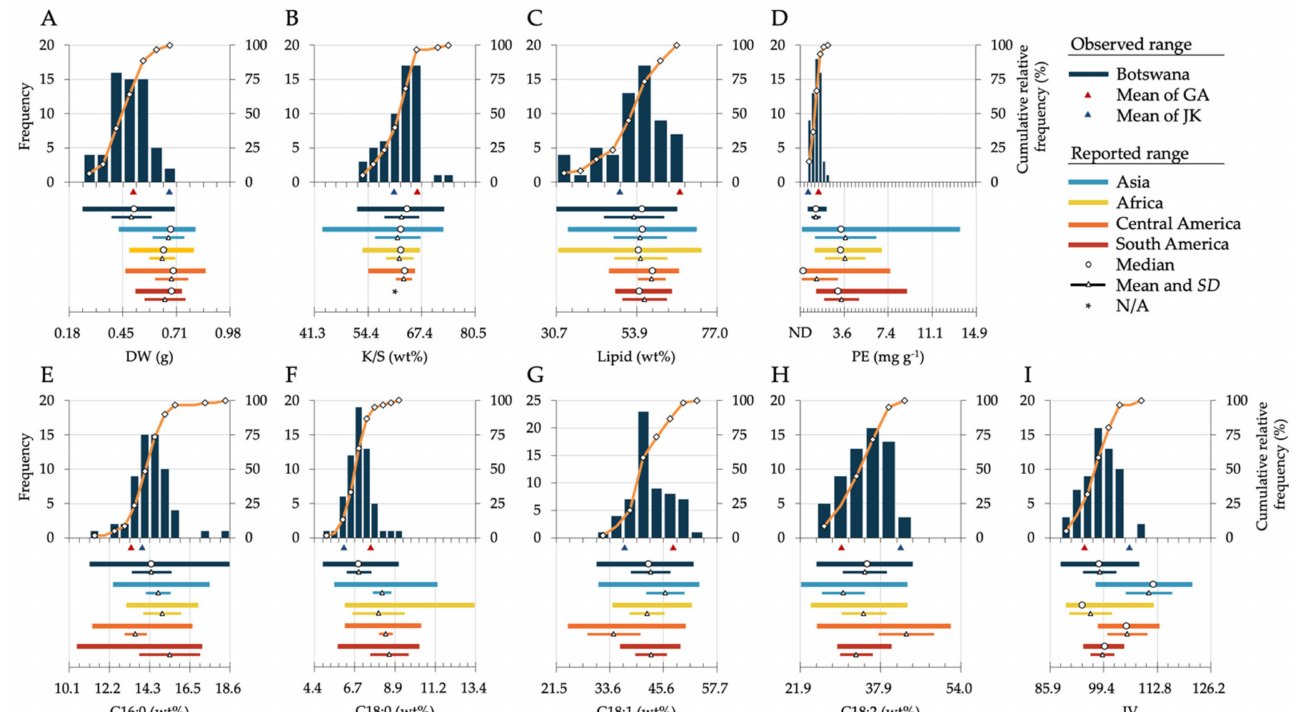
Figure 2. Frequency distribution histograms of seed physicochemical traits for the Botswanan accessions. The ( A ) dry seed weight (DW), ( B ) kernel/seed gravimetric ratio (K/S), ( C ) lipid, ( D ) phorbol ester (PE), ( E ) palmitic acid (C16:0), ( F ) stearic acid (C18:0), ( G ) oleic acid (C18:1), and ( H ) linoleic acid (C18:2) content, and ( I ) iodine values (IV) are shown. In each panel, the dark blue vertical bars corresponding to the left vertical axis scale and orange polygonal curves corresponding to the right vertical axis scale represent the frequency and cumulative relative frequency for the 60 Botswanan accessions, respectively. Their bin widths are compiled in Table S10. The values for each accession are the mean of three independent seeds (the one with the median DW and the two with the closest values on either side). Means of GA and JK accessions are shown as red and blue triangles, respectively, below the horizontal axes. The reported ranges in other regions of the world, collected in the meta-analysis, are indicated by horizontal bars below the x -axis, with their color codes and mean/median symbols shown at the top right corner. Detailed data on worldwide Jatropha seed traits for ( A – D ), and ( I ) are compiled in Supplementary Tables S4–S9. In ( E – H ), the minimum, maximum, mean, and SD data on the fatty acid compositions in each continent are adapted from published data in Osorio et al. (2014). N/A, data not